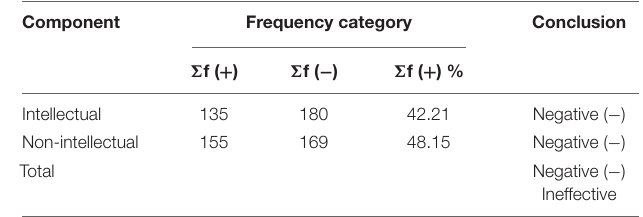
TABLE 6 | T -score analysis of the product variable